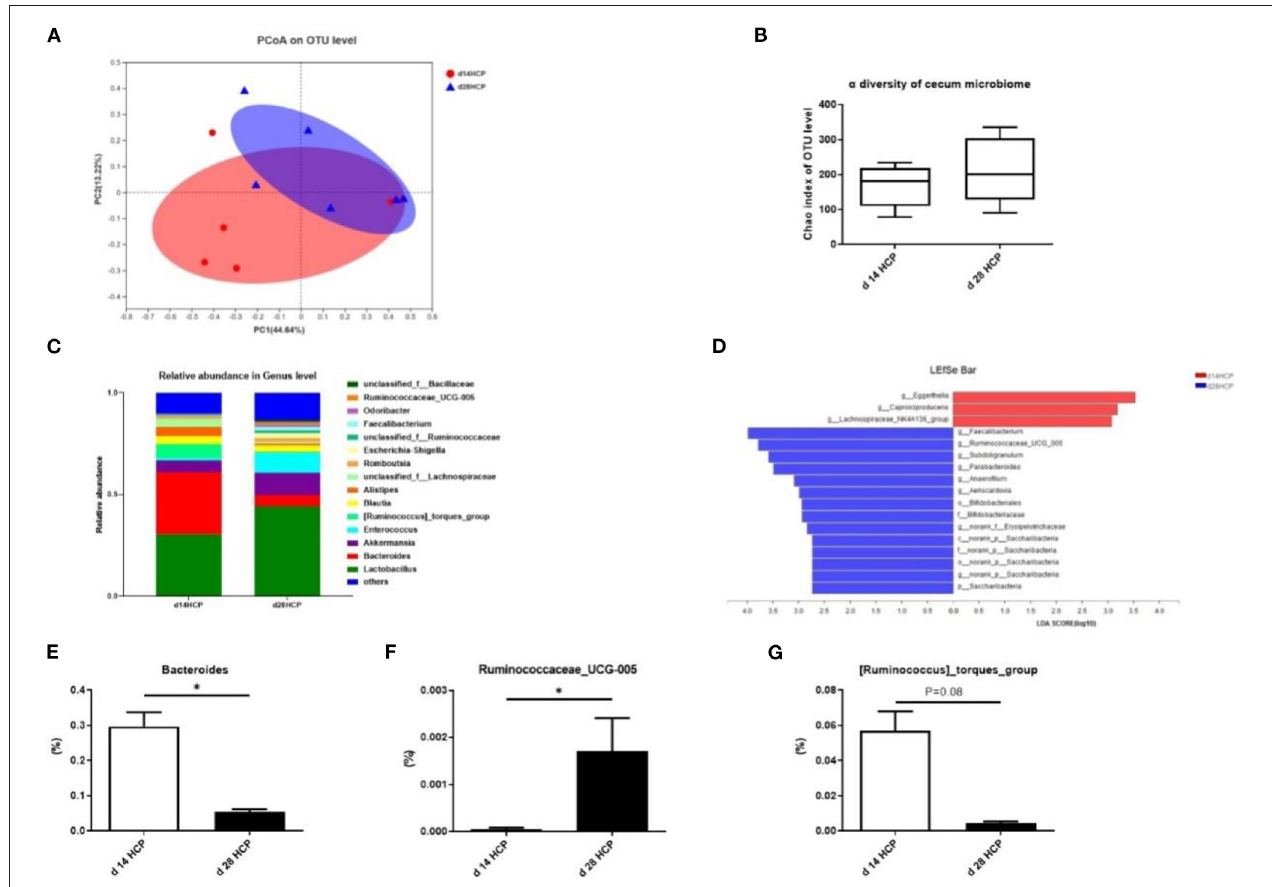
FIGURE 6 | Effect of HCP meal-based diet on cecum microbial diversity of Magang geese on day 14 and 28. (A) Principal component analysis of microbial communities in the cecum from the day 14 HCP group and day 28 HCP group. (B) Alpha diversity: Chao index. (C) Relative abundance in genus. (D) LEfSe identified the most differential under the influence of the HCP meal-based diet. The red bars represent the species with high abundances in the day 14 HCP group, and the green bars represent the species with high abundances in the day 28 HCP groups. The higher the LDA score, the more significant difference of abundance between groups. (E–G) The abundance of Bacteroides , Ruminococcaceae_UCG_005 , and [ Ruminococcus ] _torques_group between the day 14 HCP group and the day 28 HCP group. Data are expressed as mean ± SEM ( n = 6/group). Error bars represent the standard error of the mean ( n = 6/group). *Mean significant difference ( p <